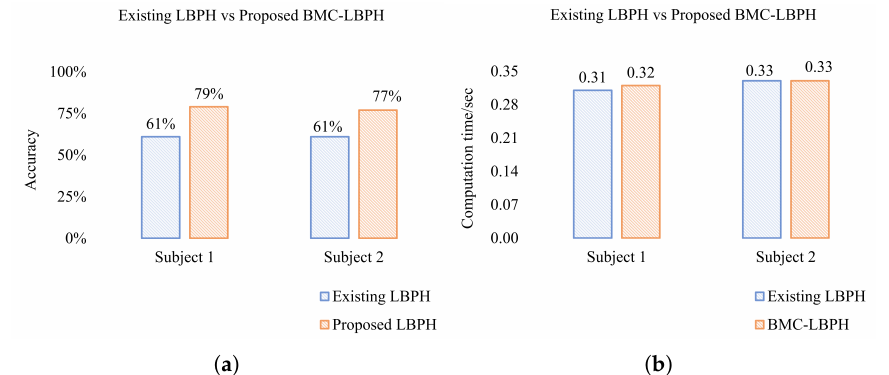
Figure 9. Comparison between LBPH and BMC-LBPH FR techniques in terms of ( a ) accuracy and ( b ) computation time for subject 1 and 2 in real-time